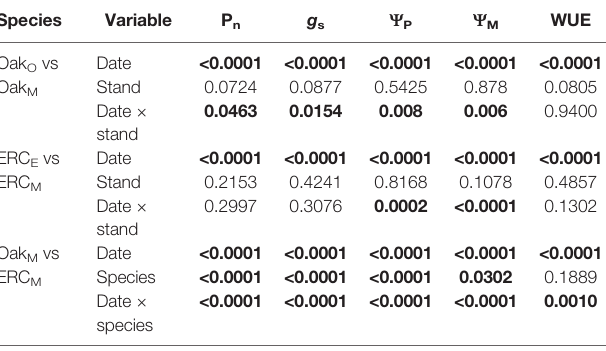
TABLE 3 | Results of PROC MIXED model with repeated measurements for the effects of date, stand, or species, and their interaction on gas exchange and water potential. Bold text indicates signi fi cance p <